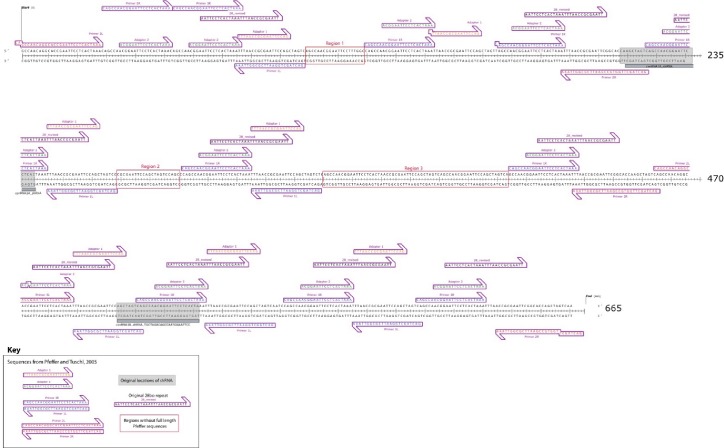
Map of re-sequenced cenRNA#1Sequence alignments revealed that cenRNA#1 is principally composed of adapters used for cloning step described in (Pfeffer et al., 2005). Only full-length, 100% identical locations of Pfeffer et al. sequences are indicated (except at sequence ends).